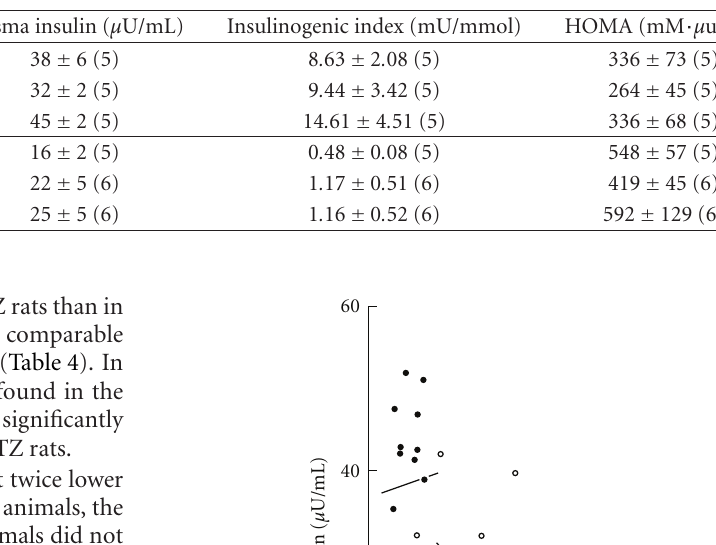
Table 4: Plasma D-glucose and insulin concentrations at sacrifice.